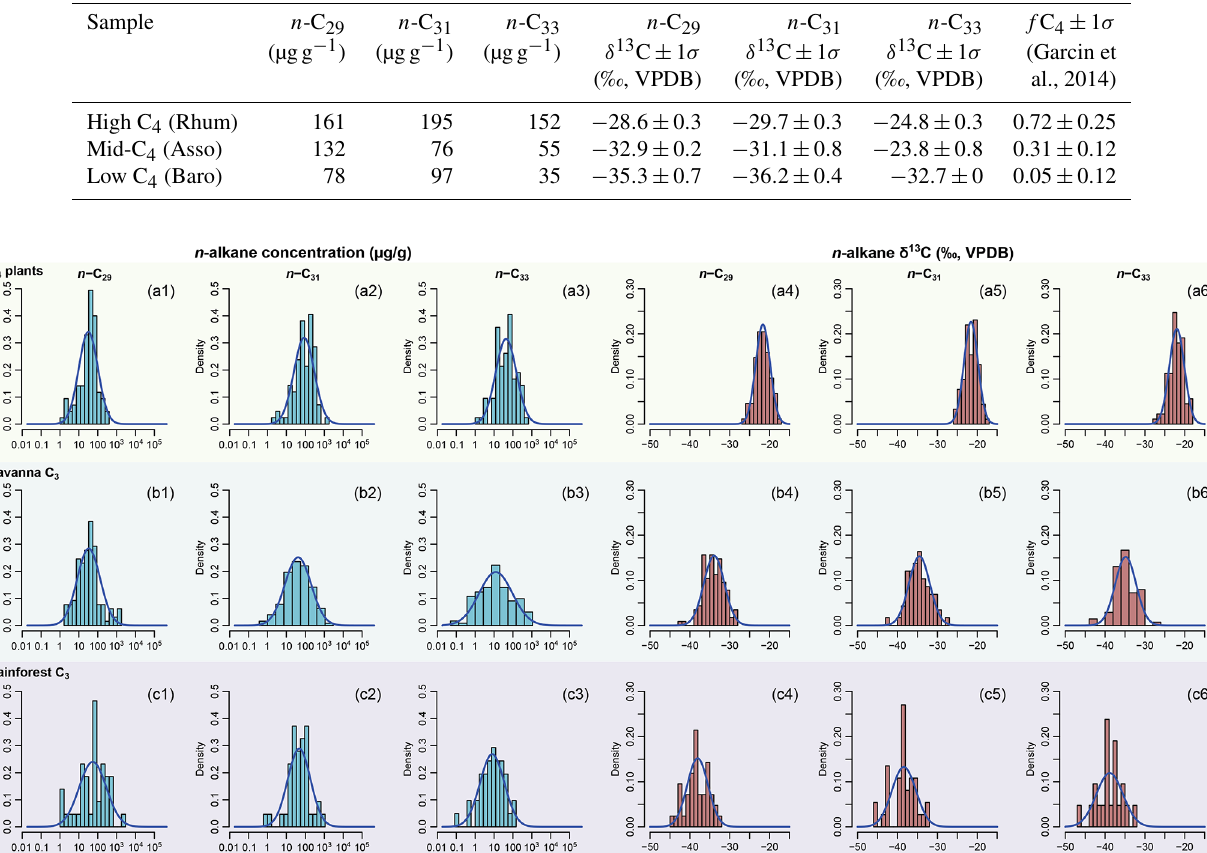
Figure 3. Empirical data of per-sample n -alkane concentrations (µgg − 1 of dried sample, blue histograms) and δ 13 C (‰, VPDB, red his- tograms) of n -C 29 , n -C 31 , and n -C 33 alkanes and their corresponding prior distributions (blue Gaussian curve overlays) of published plants in the C 4 plants, savanna C 3 , and rainforest C 3 sources. Raw data are compiled in supplementary data EA-3 (Yang, 2022). Estimated prior parameters of each source, including the means and variance-covariance matrices, are reported in Tables S3 and